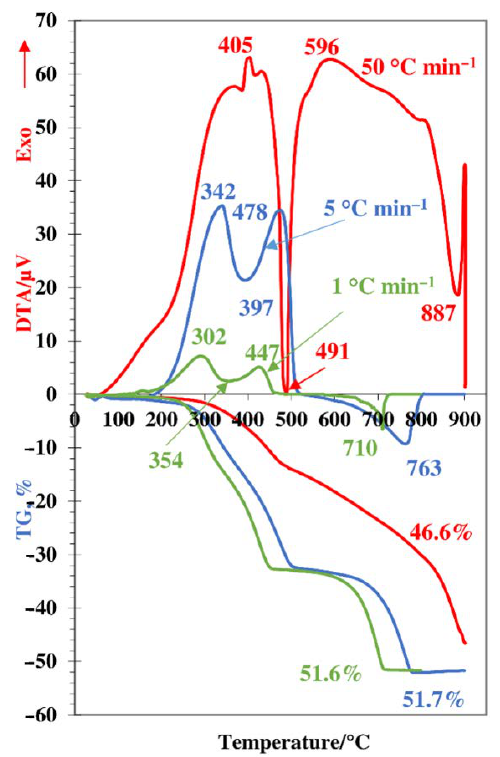
Figure 1. Thermoanalytical curves of Estonian OS I. at different heating rates.